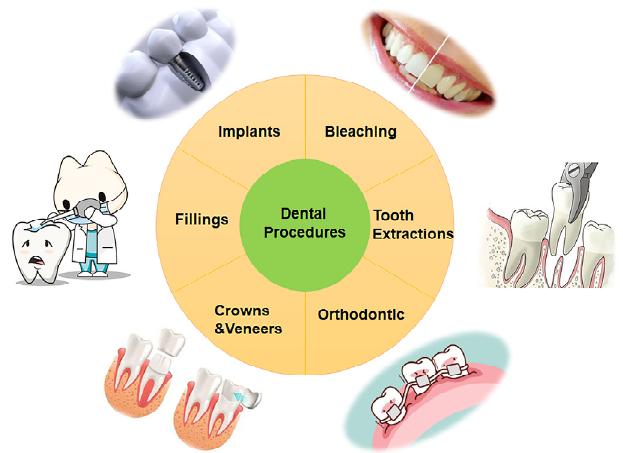
Figure 1. Sources of ROS production in dental procedures. As people are paying more attention to dental health, various dental treatment proce- dures are becoming popular, which also means that the sources of ROS are more extensive than